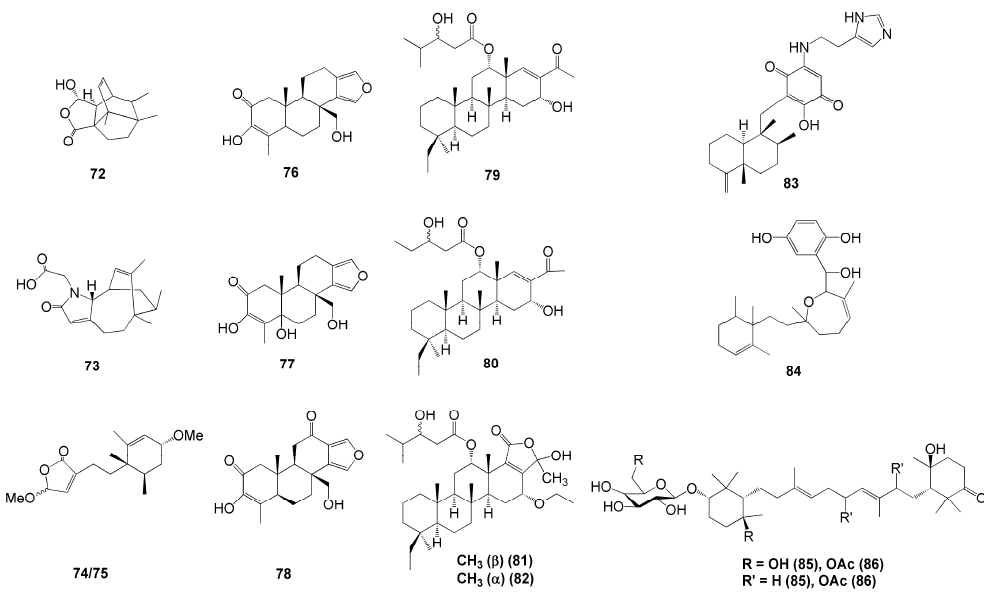
Figure 6. Chemical structures of 72–86.